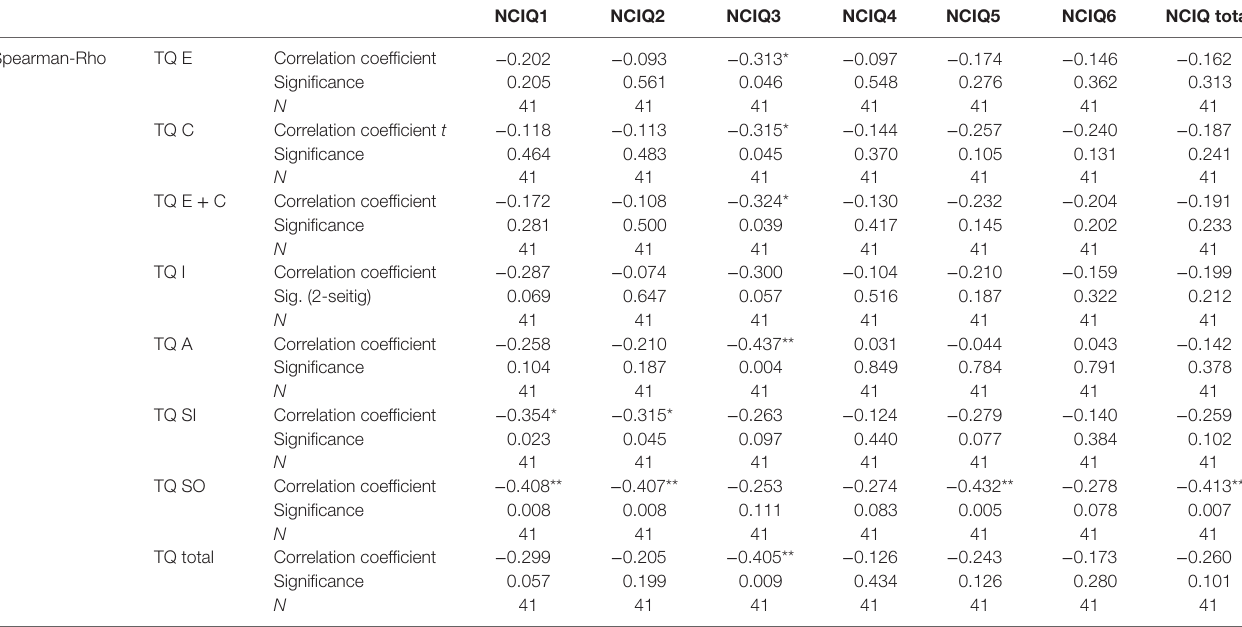
TaBle 4 | correlation between tinnitus and health-related quality of life before cochlear implantation.